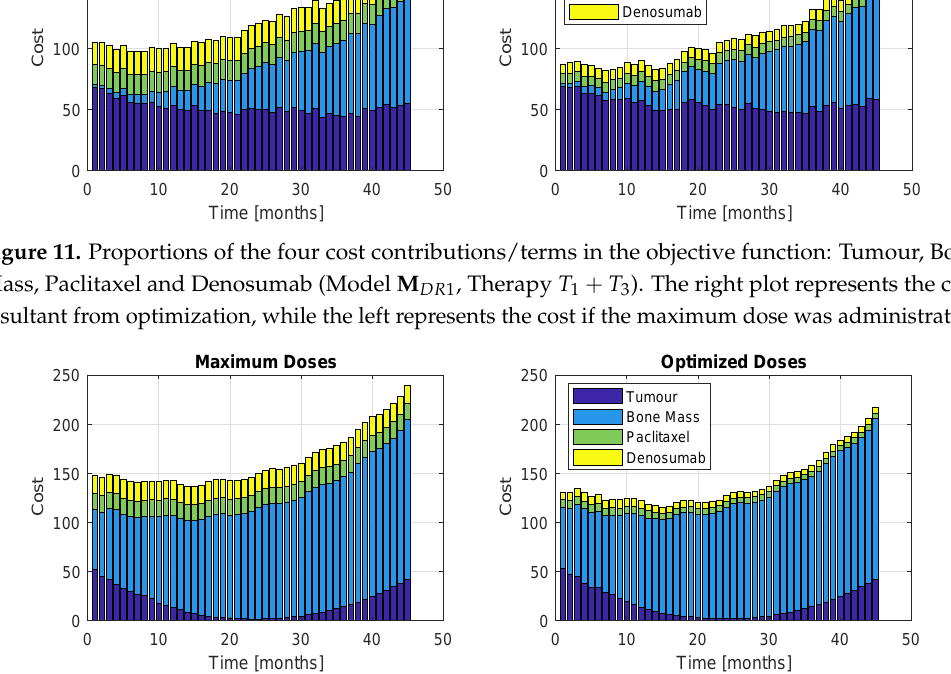
Figure 12. Proportions of the four cost contributions/terms in the objective function: Tumour, Bone Mass, Paclitaxel and denosumab (Model M DR 2 , Therapy T 1 + T 3 ). The right plot represents the cost resultant from optimization, while the left represents the cost if the maximum dose was